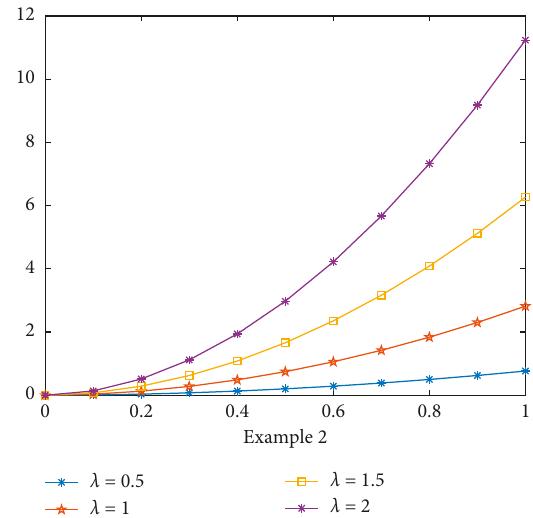
Figure 2: Dependence of the solution v ∗ Table 3: Numerical value of the solution v ∗